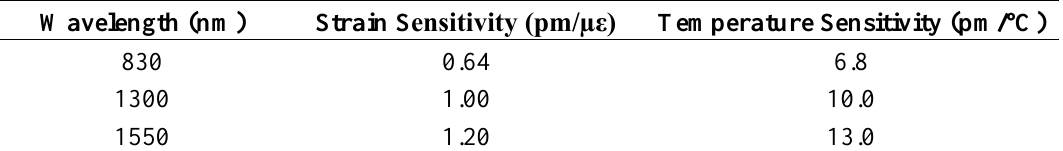
Table 1. FBG strain and temperature sensitivities at different